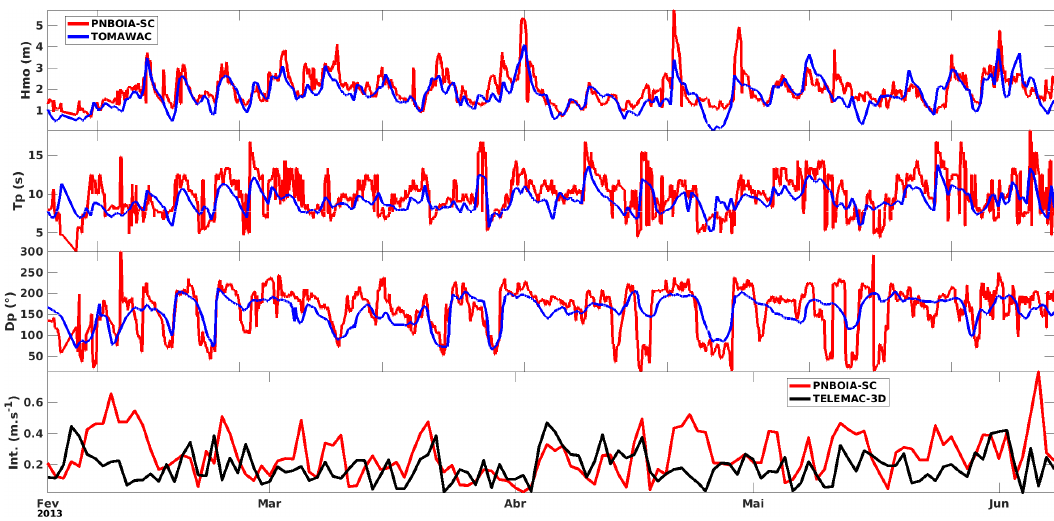
Figure 2. Time series of spectral significant wave heights (m), peak period (s) peak direction (°) from TOMAWAC (blue), and velocity intensity (m · s − 1 ) from TELEMAC-3D (black), compared against the observed data from the Santa Catarina PNBOIA buoy (red).